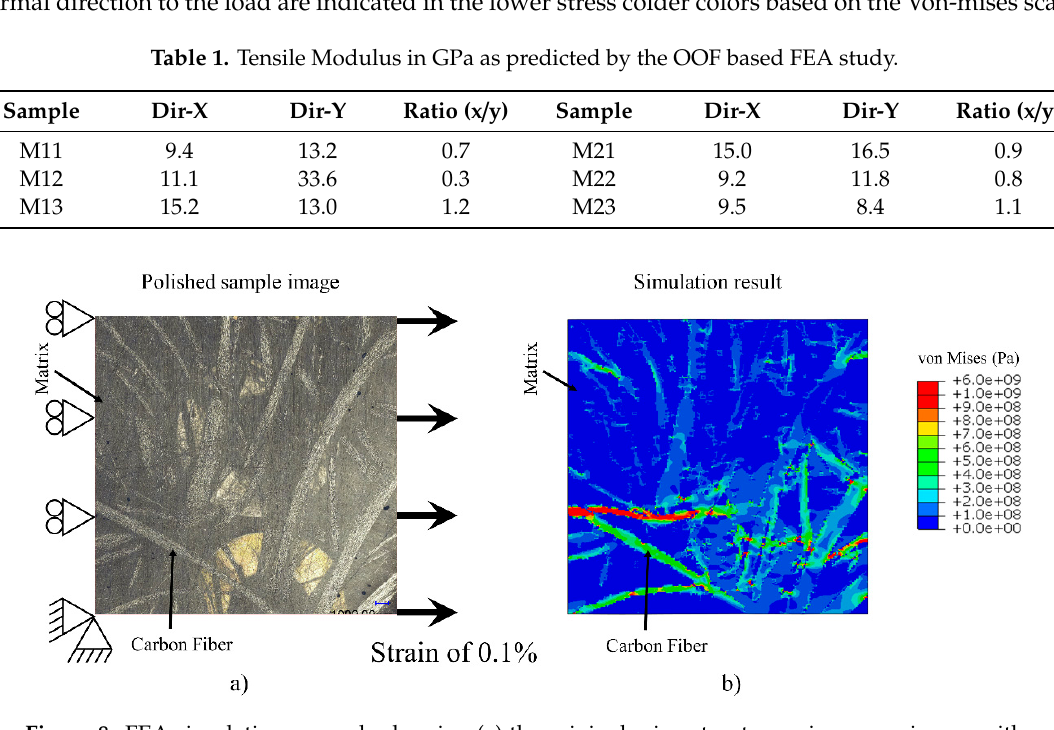
Figure 8. FEA simulation example showing ( a ) the original microstructure microscope image with the loading direction and ( b ) the fibers in the loading direction, bear the load and highlighted in warm colors. While the fibers that are perpendicular to the load direction remain in cold colors as they do not contribute to carrying the load.